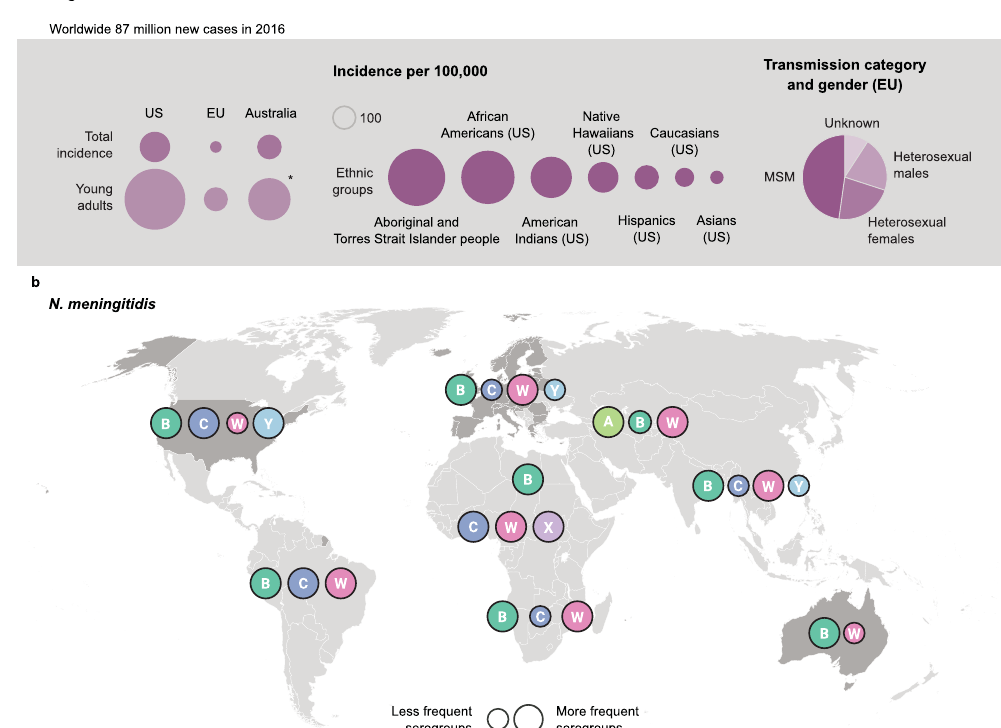
Fig. 1 Incidence of gonorrhea #8 and global distribution of Neisseria meningitidis serogroups causing invasive meningococcal disease in 2019 (adapted from $). a Total incidence of gonorrhea in the United States (US), the European Union (EU), and Australia as well as incidence for young adults aged 20 – 24 years in 2018, incidence per ethnic group for Australia (Aboriginal and Torres Strait Islander people) and the US, and distributions per transmission category and gender for the EU. b The distribution of N. meningitidis serogroups and the countries where the incidence of gonorrhea is reported accurately in young adults (dark gray). A/B/C/W/X/Y meningococcal serogroup A/B/C/W/X/Y; MSM men who have sex with men. *Aged 20 – 29 years and data for 2017. # https://kirby.unsw.edu.au/sites/default/ fi les/kirby/report/KI_Annual-Surveillance- Report-2018.pdf; https://www.cdc.gov/std/stats18/tables/21.htm; https://www.cdc.gov/std/stats18/gonorrhea.htm; https://www.ecdc.europa.eu/ sites/default/ fi les/documents/gonorrhoea-annual-epidemiological-report-2018.pdf. $ https://www.who.int/images/default-source/health-topics/ meningitis/map-serogroup-distribution-2019.png?sfvrsn =